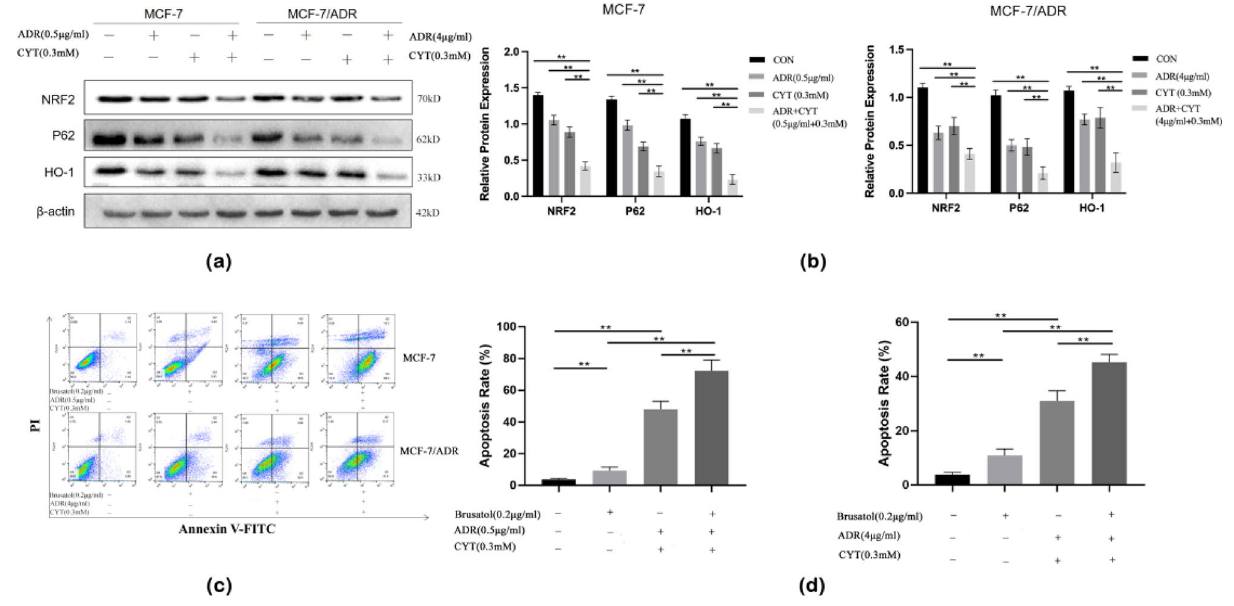
Figure 4. CYT combined with ADR Induced MCF-7 and MCF-7/ADR cells apoptosis by inhibiting the NRF2/ ARE signaling pathways. ( a ) ADR + CYT reduced the expression levels of P62, NRF2, and HO-1 in MCF-7 cells and MCF-7/ADR cells. ( b ) The bar chart showed the mean ± S.D. of three experiments. β-actin was the internal control. ( c ) Brusatal promotes ADR + CYT-induced apoptosis in MCF-7 and MCF-7/ADR cells. ( d ) The bar chart showed the mean ± S.D. of three experiments.** p < .01.